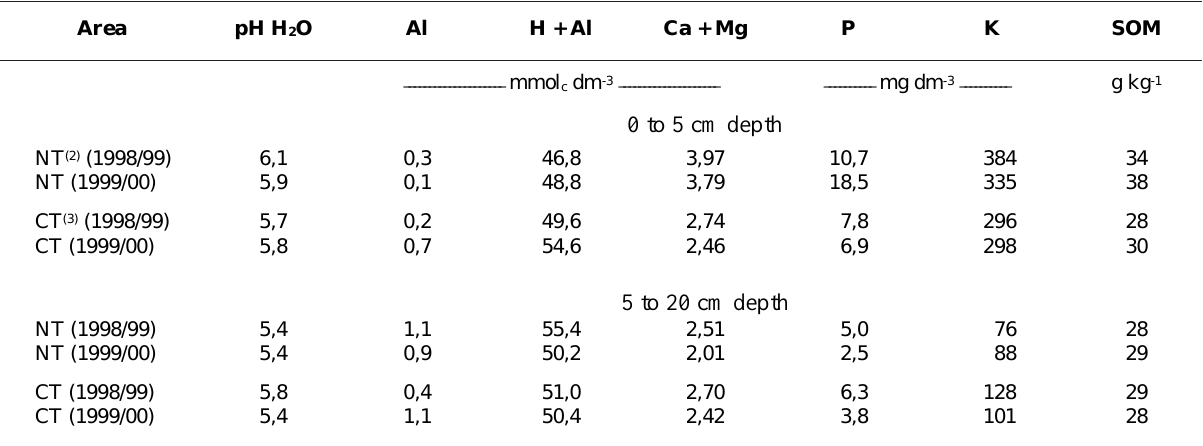
Table 1. Chemical soil properties of soil samples collected from the four sites where the experiments were carried out. Results from a composite soil sample collected before planting (1)